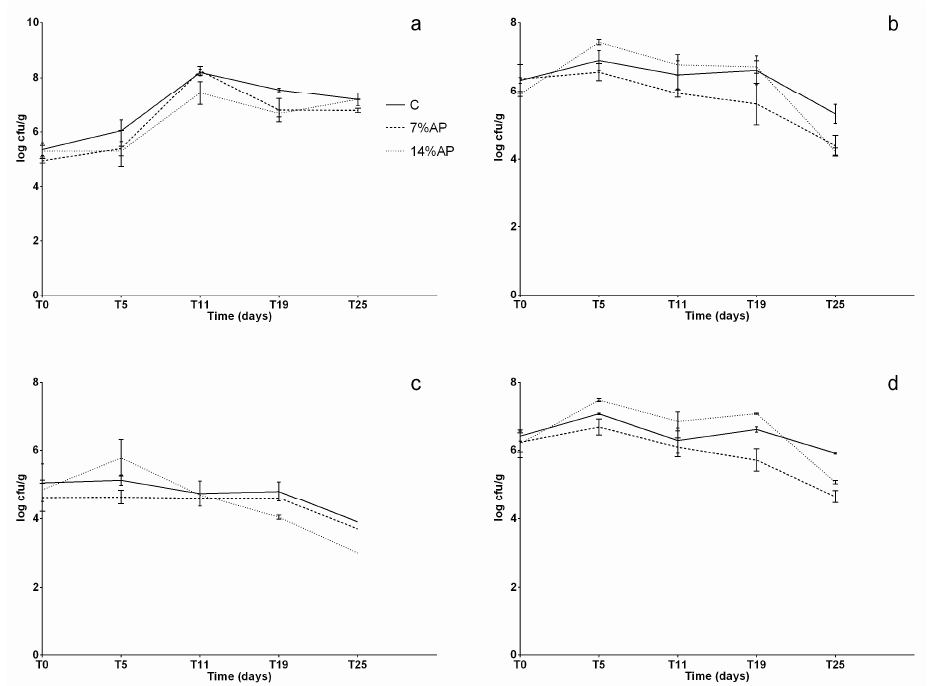
Figure 4. Microbiological analysis of spoilage and potential foodborne pathogen bacteria during the ripening. ( a ) BP, Baird Parker agar, Staphylococcus spp.; ( b ) VRBG, violet red bile glucose agar, Enterobacteriaceae ; ( c ) VRBL, violet red bile lactose agar, total coliforms; ( d ) PS103 pseudomonas agar, Pseudomonas spp.